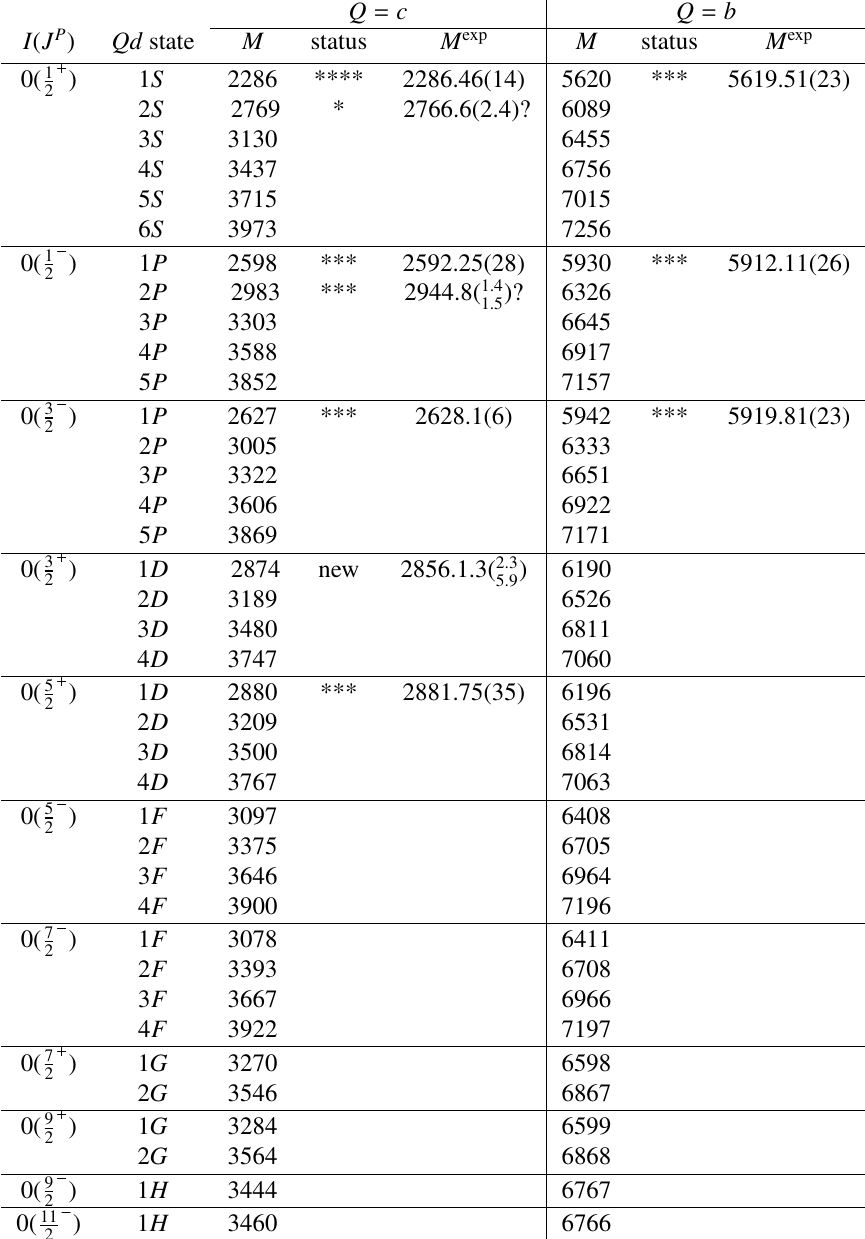
Table 1. Masses of the Λ Q ( Q = c , b ) heavy baryons (in MeV) Q = c Q =